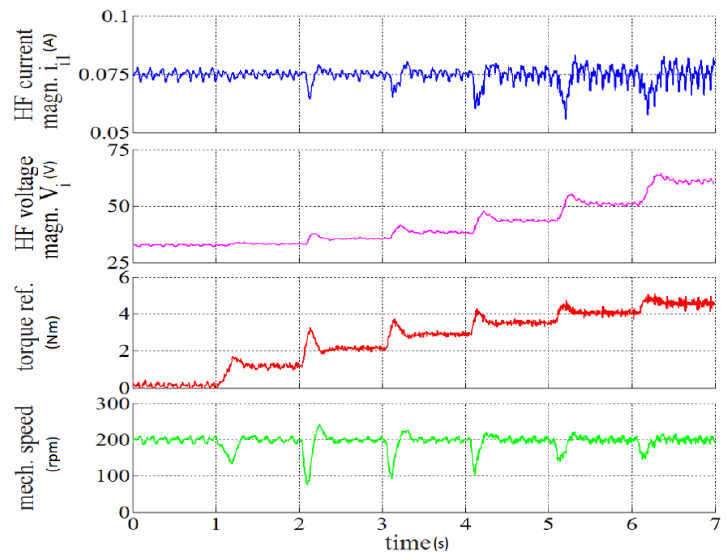
Figure 15. Motor #1: Sensorless speed control ( 𝑖 𝑑∗ = 0 ), gain adaptation and 𝑖 𝑖1 regulation: 200 rpm, 1-Nm steps from 0 to 6 Nm.